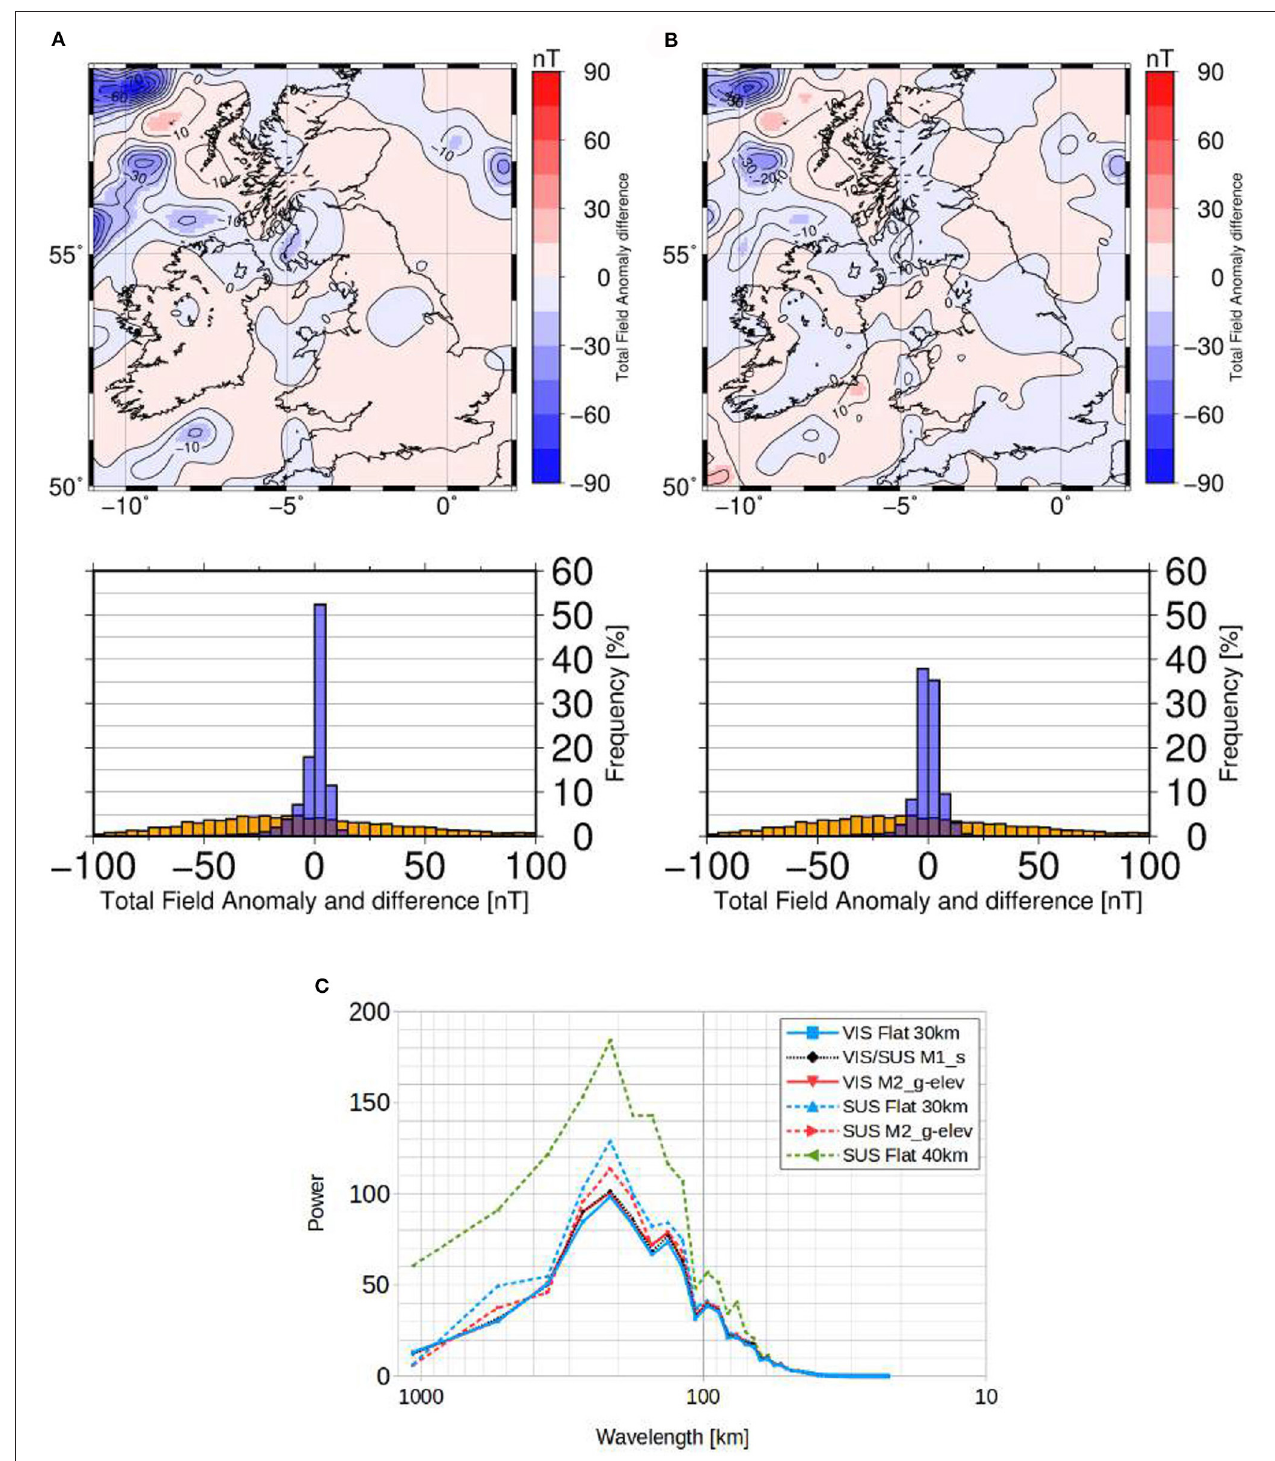
FIGURE 11 | (A) Difference between the calculated magnetic anomaly for model M1_s ( Figure 10A ) and for a flat model (30 km constant Curie depth) with the same susceptibility distribution as in M1_s . Below: histogram of values in EMAG2 dataset (orange) and in this difference map (blue) (B) Difference between the calculated magnetic anomaly for model M1_s ( Figure 10A ) and for model M2_g-elev with the same susceptibility distribution as in M1_s . Underneath: histogram of values in EMAG2 dataset (orange) and in the difference map (blue). (C) Estimated power spectrums in the radial direction of five magnetic models, where VIS means models with VIS from Hemant (2003), and SUS means models with susceptibility distribution from M1_s .